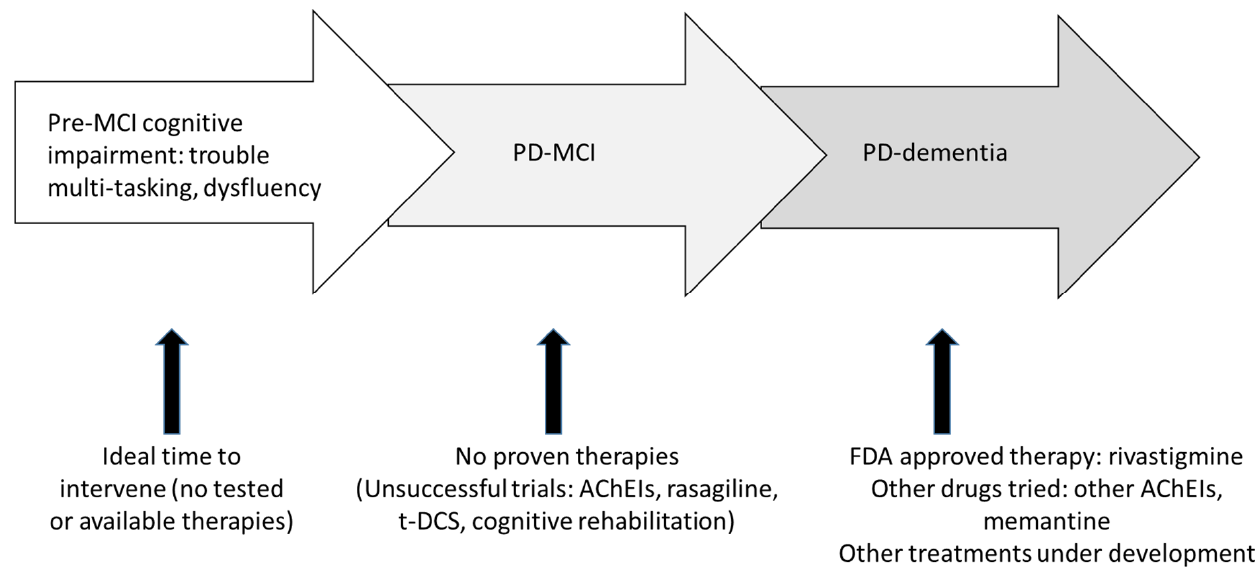
Figure 1. Approach to treating cognitive impairment in Parkinson’s disease. AchEI: acetylcholinesterase inhibitors. T-DCS: transcranial direct current stimulation. Table 2. Clinically available pharmacologic treatments for cognition in Parkinson’s disease mild cognitive impairment and Parkinson’s disease dementia.